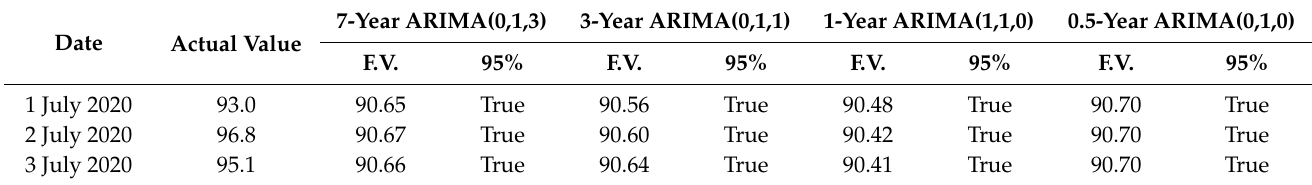
Table 3. Comparison of the predicted and actual values of each data interval for 3083 Chinese Gamer.